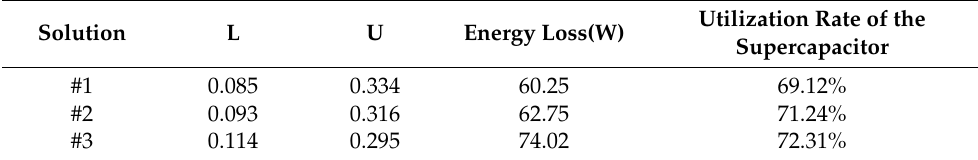
Table 2. The solution point of the Pareto